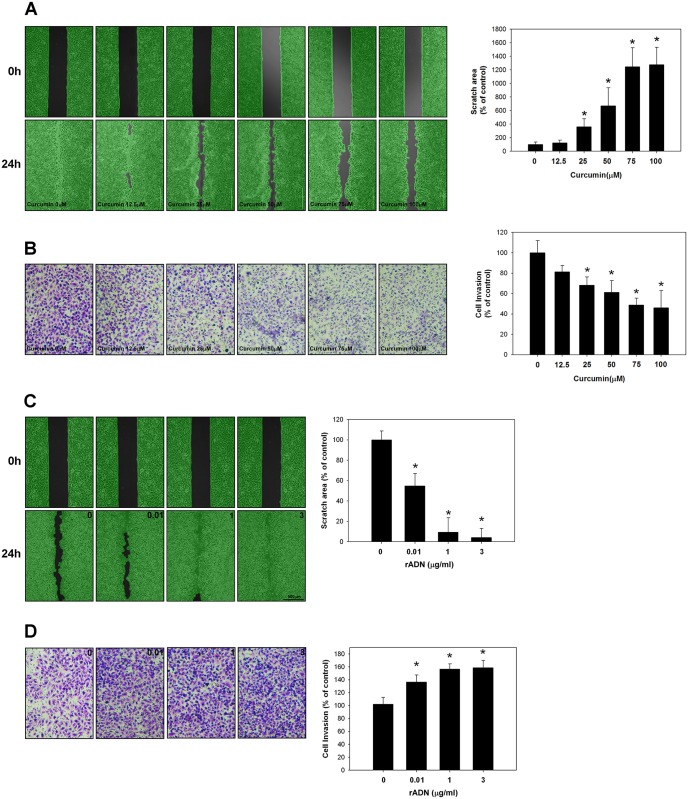
Effects of curcumin and recombinant adiponectin on the invasiveness/migration of A549 cells.
(A) Cellular migration was determined using scratch wound assay and analyzed using the Wimasis WimScratch software. The migratory ability of A549 cells was significantly inhibited by increasing curcumin dosage compared with the control group (p < 0.05). (B) Invasiveness was determined by Matrigel-coated Boyden chamber assay. Curcumin significantly decreased the invasive ability of A549 cells (p < 0.05) when the curcumin concentration was >25 uM. (C–D) The application of recombinant adiponectin (rADN) significantly increased the migratory and invasive ability of A549 cells (p < 0.05). The results of three independent experiments are shown; the assays were conducted in triplicate.